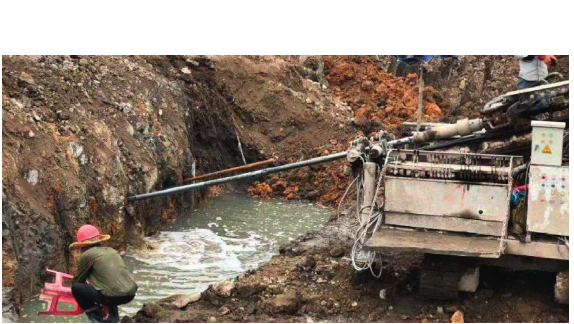
Figure 10: Field trepanning by crawler bolt drilling machine.